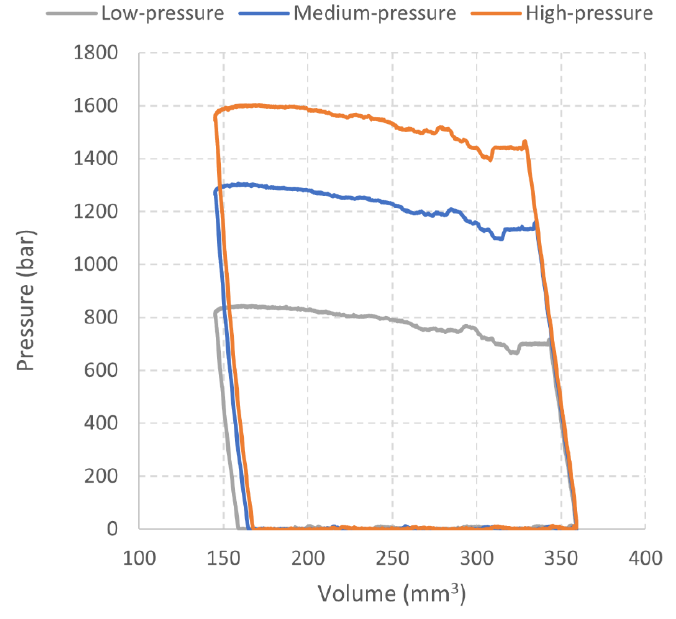
Figure 9. PWC diagrams for Low-, Medium-, and High-Pressure levels, D100-1500 RPM.